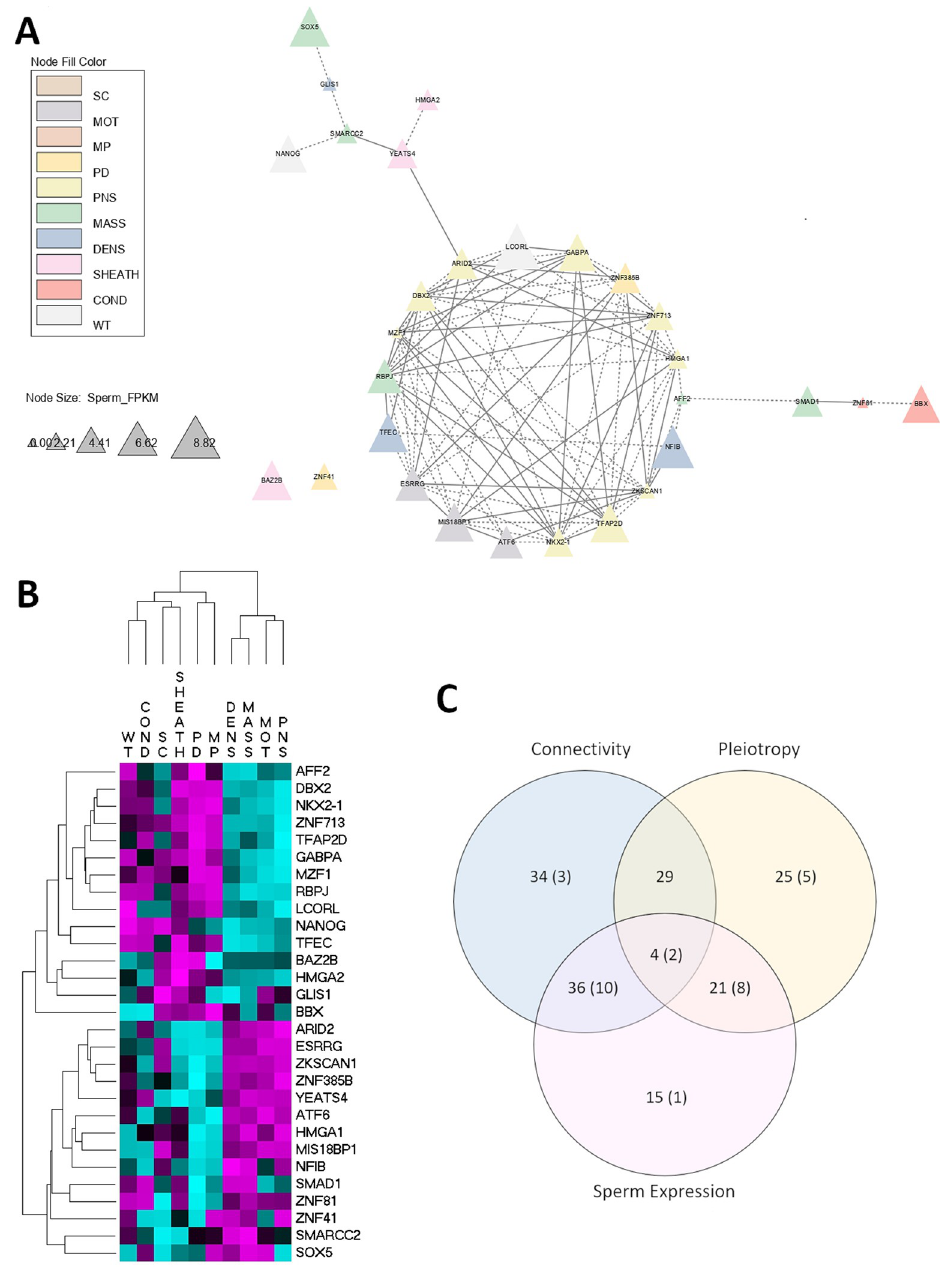
Fig 3. Genes highlighted through functionality analysis. (A) Network containing the 29 genes selected as top10 in either connectivity, pleiotropy and/or sperm expression, extracted from a bigger network containing their directly correlated genes (S2 Fig in S1 File)–continuous and dashed edges correspond to positive and negative correlations, respectively; and colors correspond to the most associated trait (SC = scrotal circumference; MOT = motility; MD = midpiece abnormalities; PD = proximal cytoplasmic droplets; PNS = percent normal sperm; MASS = mass; DENS = density; SHEATH = sheath score; COND = condition score; and WT = body weight). (B) Co-association scores (AWM output) of the 29 genes. (C) Number of transcription factors (TF) selected for being above average according to connectivity, pleiotropy, and sperm expression–the 29 top10 TF for the three selection criteria are represented in parenthesis–Refer to S3 Fig in S1 File, for the complete list of